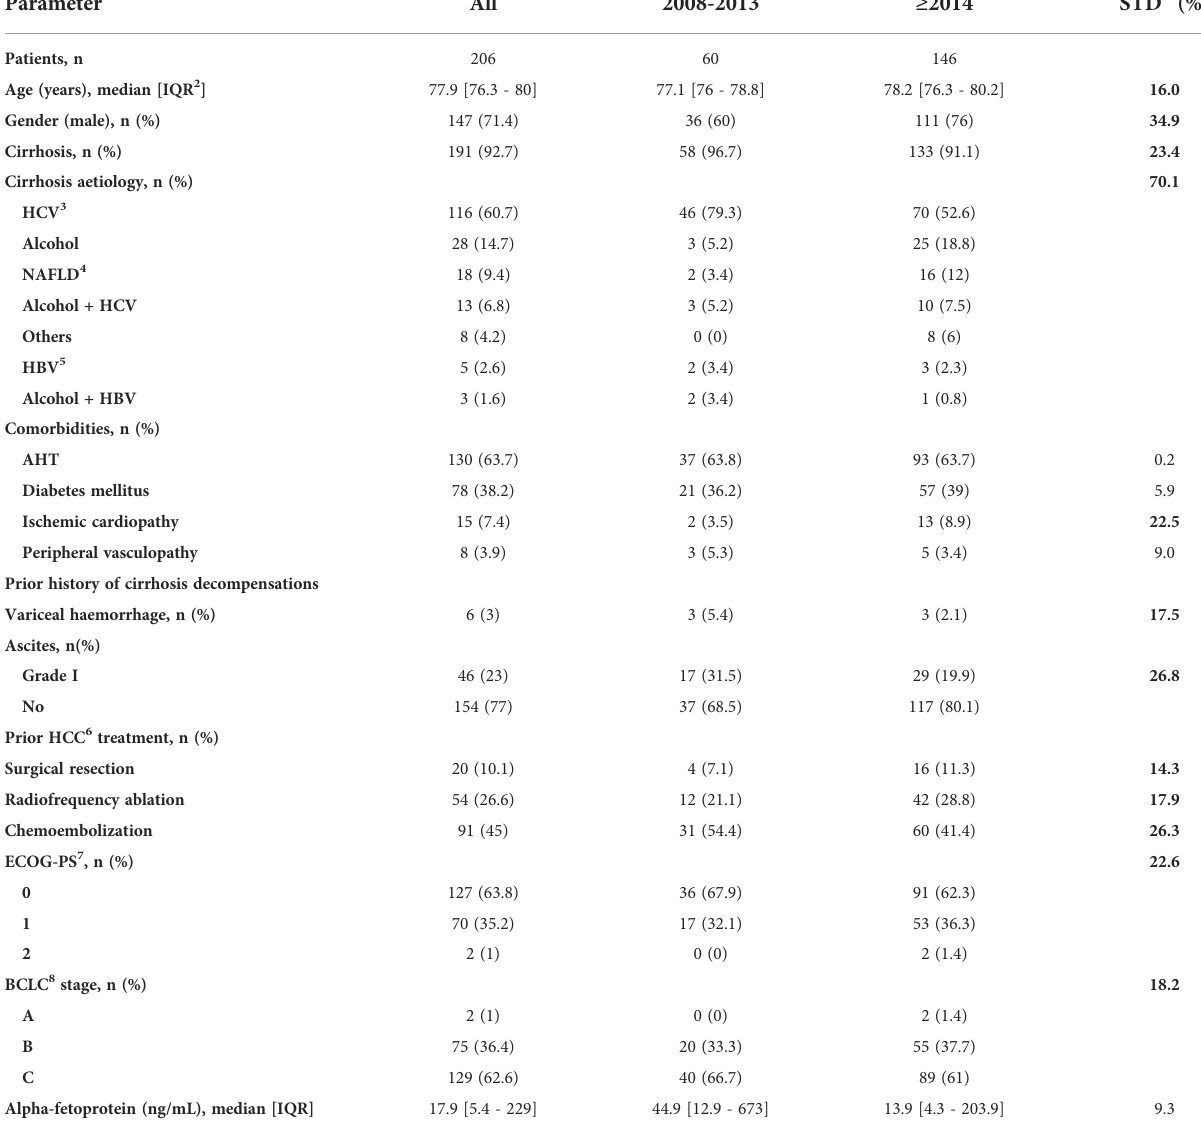
TABLE 6 Population baseline characteristics at sorafenib initiation according to period of